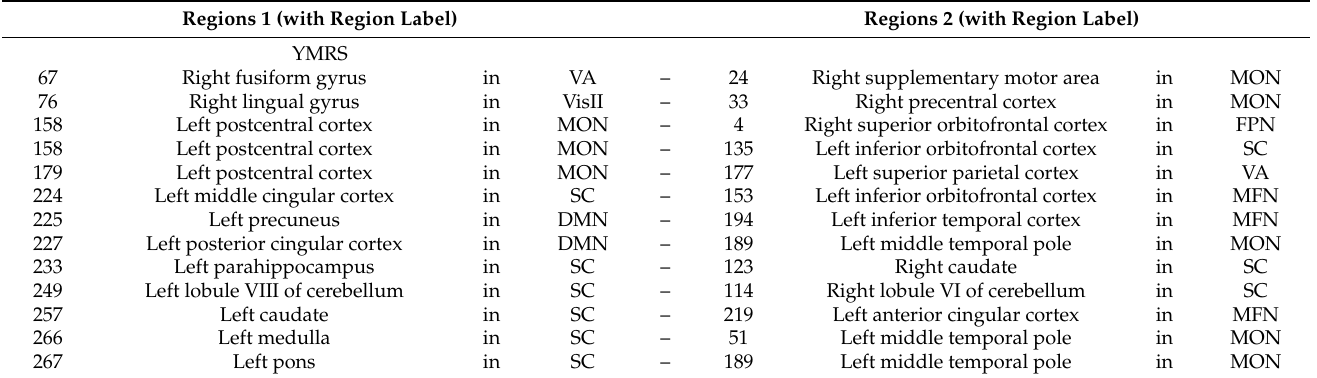
in MON – Right superior orbitofrontal cortex